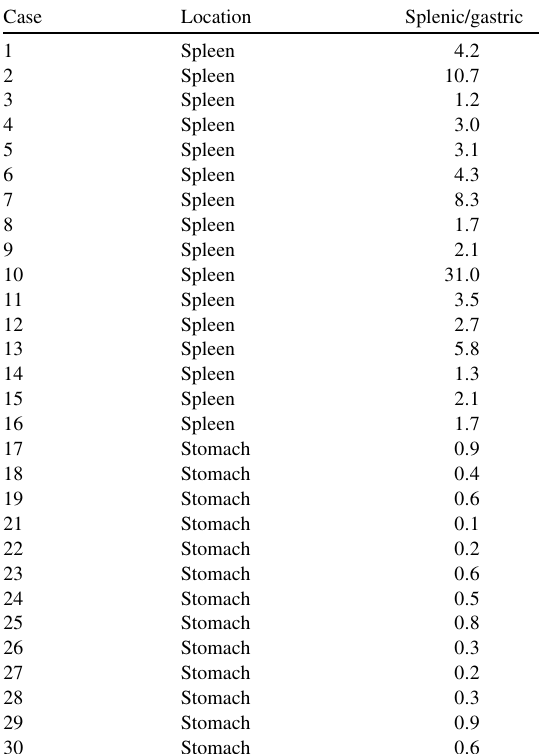
Ratio of the number of nuclei classified as “splenic” or “gastric” by the neural network and the true location of the